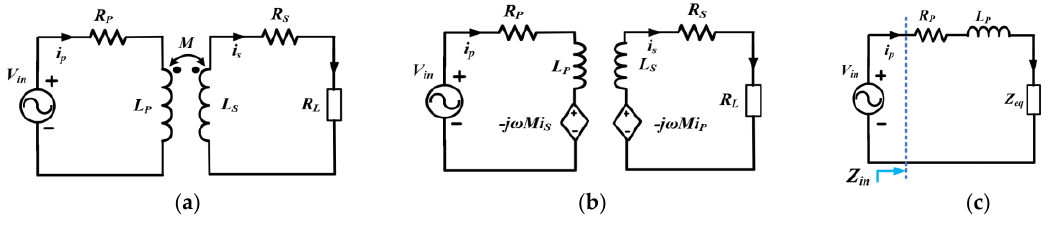
Figure 7. General IPT system without compensators, ( a , b ) circuit diagram of mutual inductance model, and ( c ) equivalent circuit reflected in the primary side.